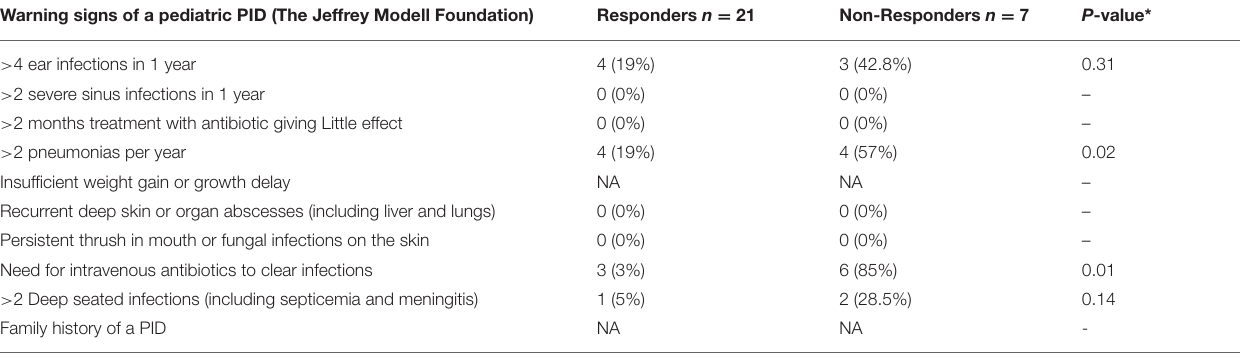
TABLE 1 | Comparison of the TV R and NR clinical characteristics with the Jeffery Modell Warning Criteria for pediatric PIDs. Warning signs of a pediatric PID (The Jeffrey Modell